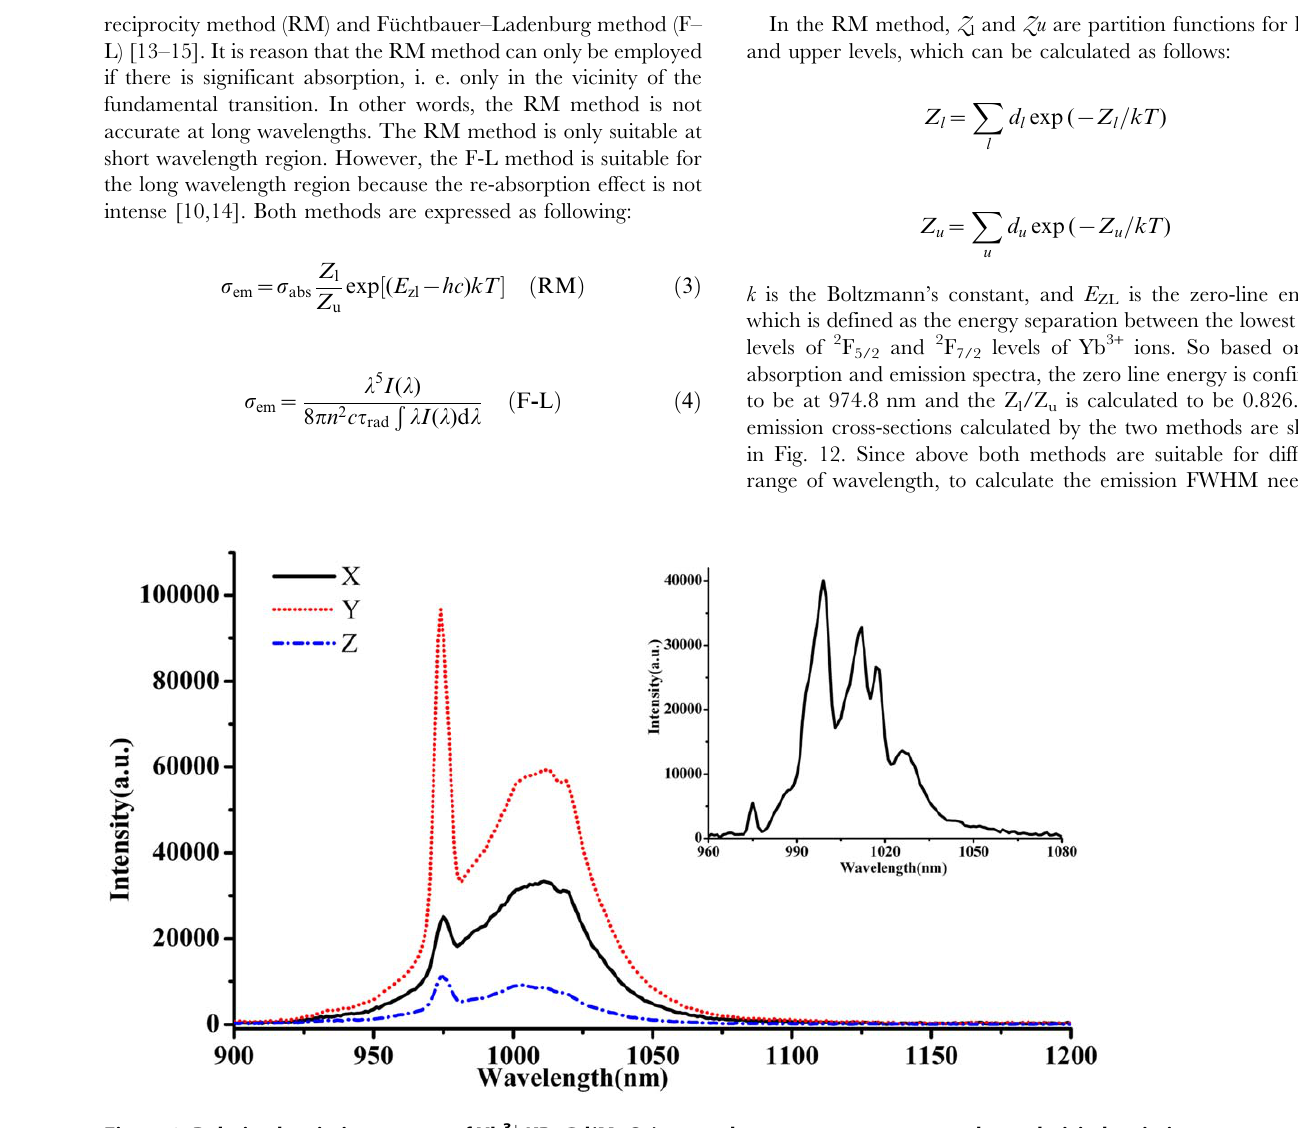
Figure 9. Polarized emission spectra of Yb 3 + :KBaGd(MoO 4 ) 3 crystal at room temperature and unpolarizied emission spectra at 10 K